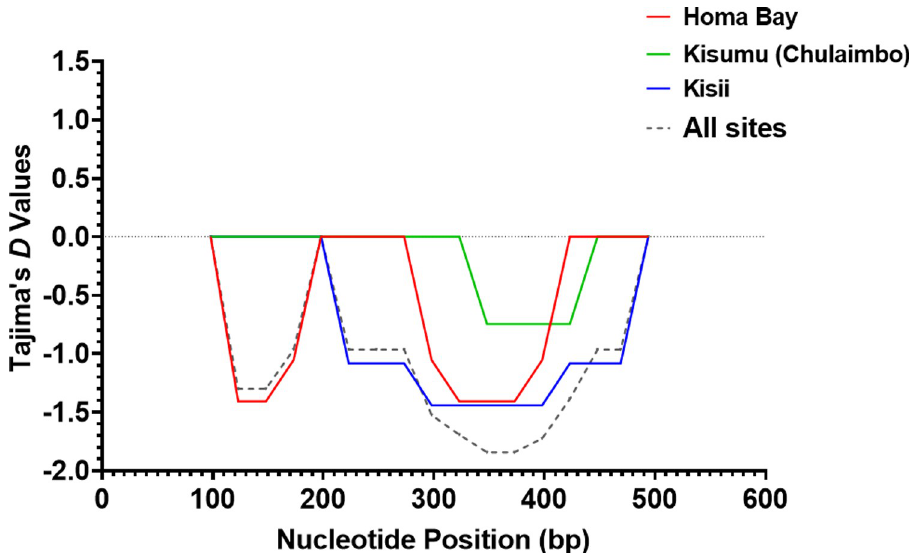
Fig 4. Sliding window plot of Tajima’s D values for Pfs25 gene in western Kenya. The X-axis displays the nucleotide position (Window midpoint) whereas the Tajima’s D values are represented on the Y-axis. The red curve represents computed Tajima’s D value for Pfs25 sequences from P . falciparum circulating in Homa Bay, the green colour is for Chulaimbo, the blue colour is for Kisii whereas the black dotted colour represents the population from the three study sites. The middle horizontal dotted line (intersecting the Y-axis at 0.0) represents a standard neutral model where the Tajima’s D value is equal to zero. Positive deviation from the grey dotted line signifies balancing selection whereas negative deviation represents purifying